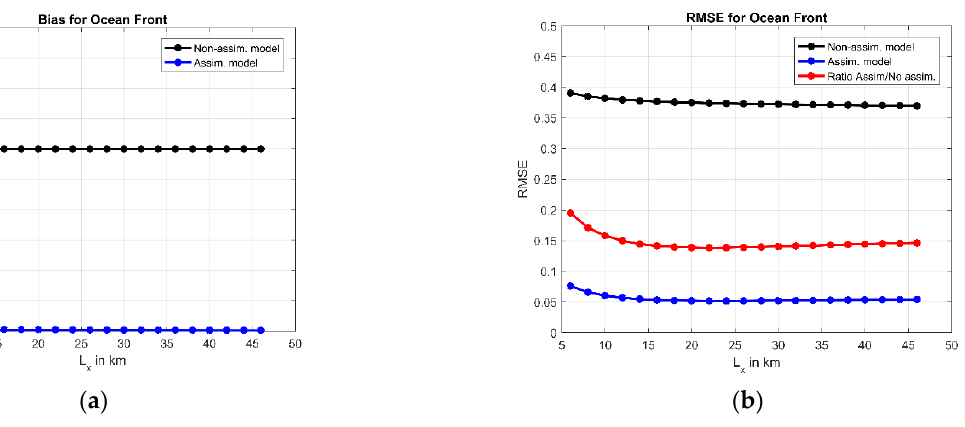
Figure 5. Plots of bias ( a ) and RMSE ( b ) for the ocean front case with different front sharpness for non-assimilated (black) and assimilated (blue) child models. The red line shows the ratio of assimilated to non-assimilated RMSE.